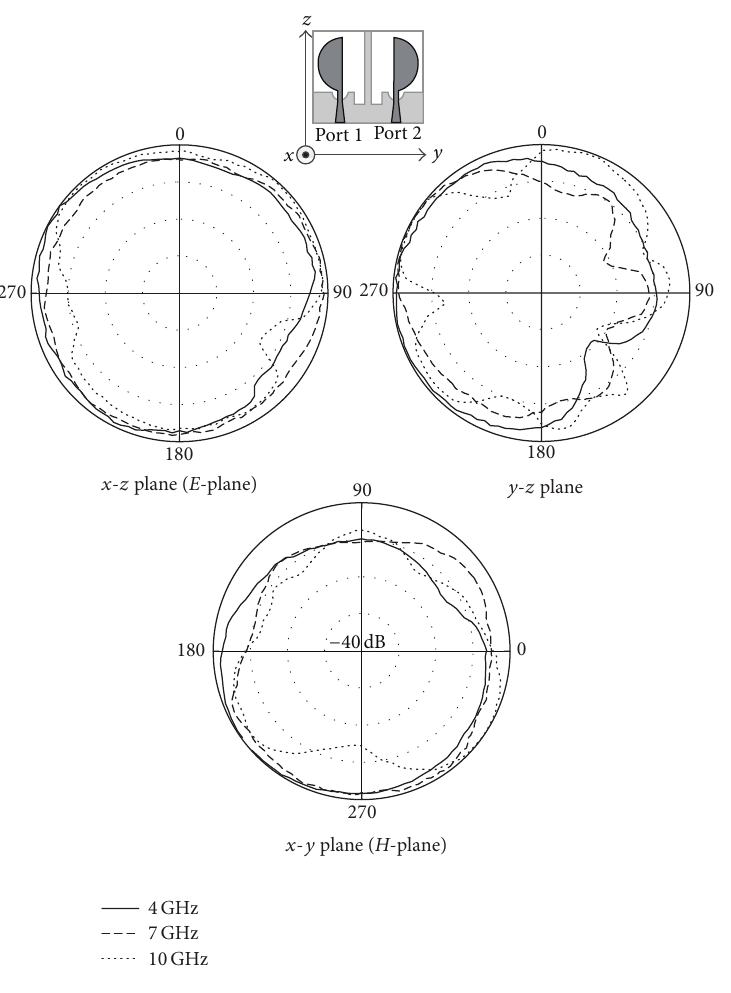
Figure 5: Measured radiation patterns of the proposed